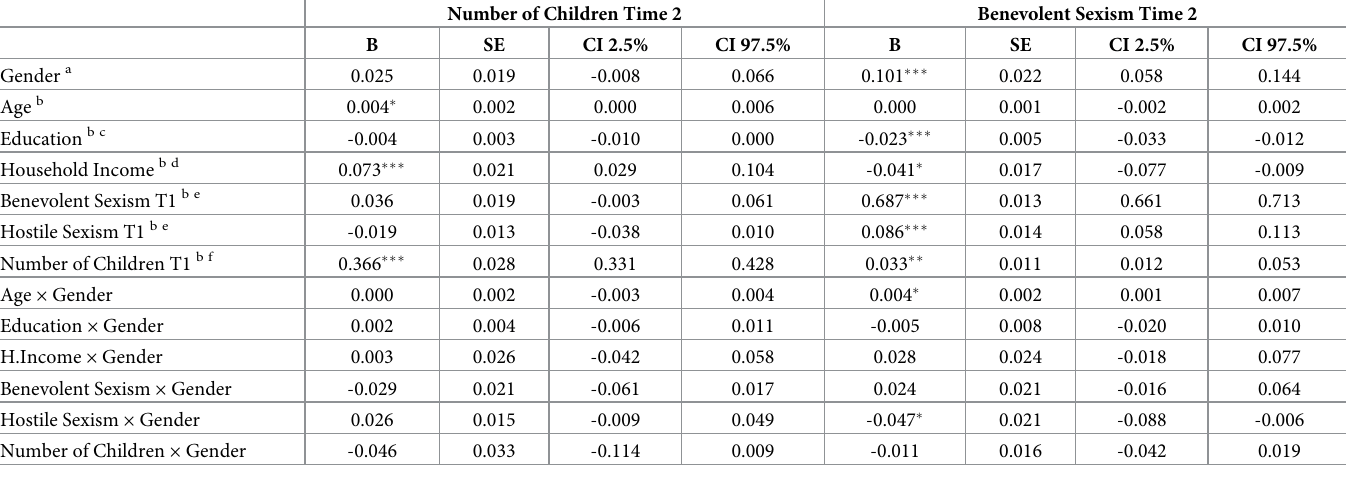
Table 3. Cross-lagged panel analysis predicting number of children and benevolent sexism over a two-year